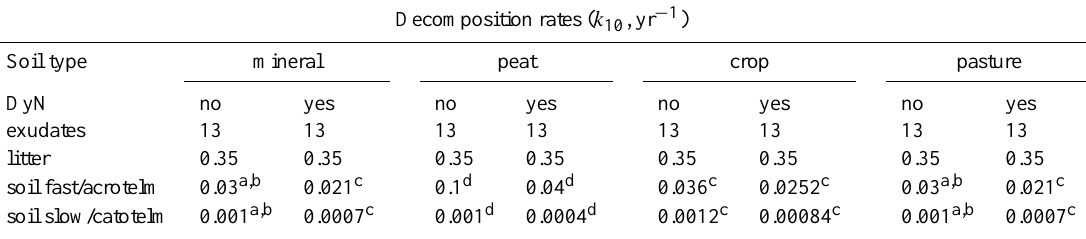
Table 1. Decomposition rates ( k 10 , yr − 1 ) of different carbon pools in LPX at a temperature of 10 ◦ C and with water content for maximum decomposition. Decomposition rates are given for model runs with and without dynamic N cycle (DyN), and for different soils: mineral soils with natural vegetation, peat soils with natural vegetation, and agricultural soils with crops or pasture. All litter and soil decomposition rates are independent of plant functional